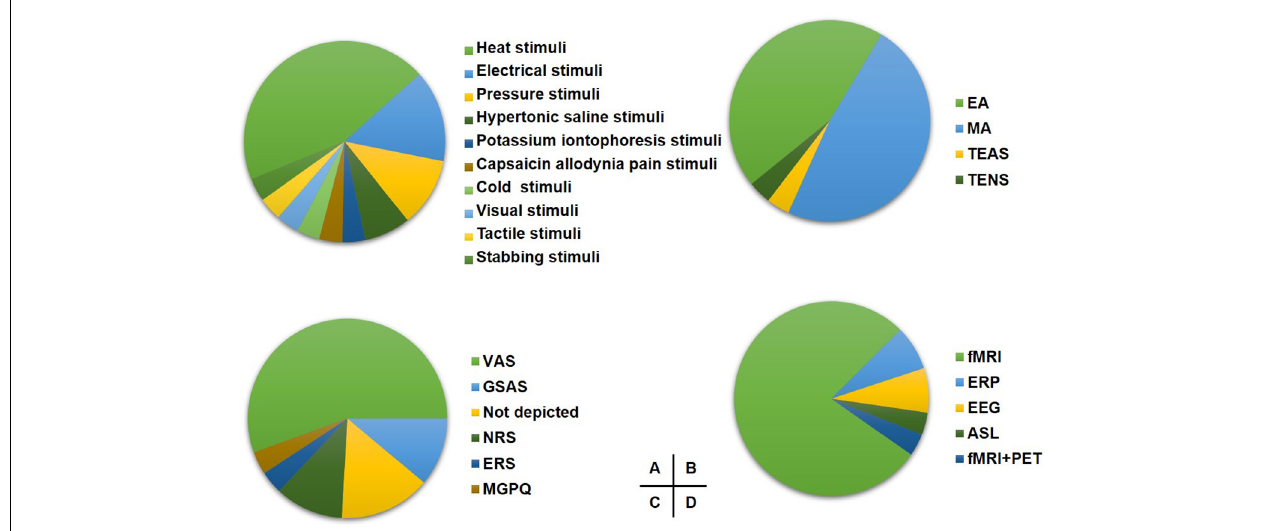
FIGURE 1 | The study design of included studies. (A) The proportion of induced pain modality. (B) The proportion of acupuncture modality for experimental pain. (C) The proportion of pain assessment scale. (D) The proportion of imaging techniques. EA, electroacupuncture; MA, manual acupuncture; TEAS, transcutaneous electrical nerve stimulation; TENS, transcutaneous electrical nerve; VAS, visual analog scale; GSAS, gracely sensory and affective scales; NRS, numerical rating scale; ERS, expectations for relief scale; MGPQ, McGill pain questionnaire; fMRI, functional MRI; ERP, event-related potential.